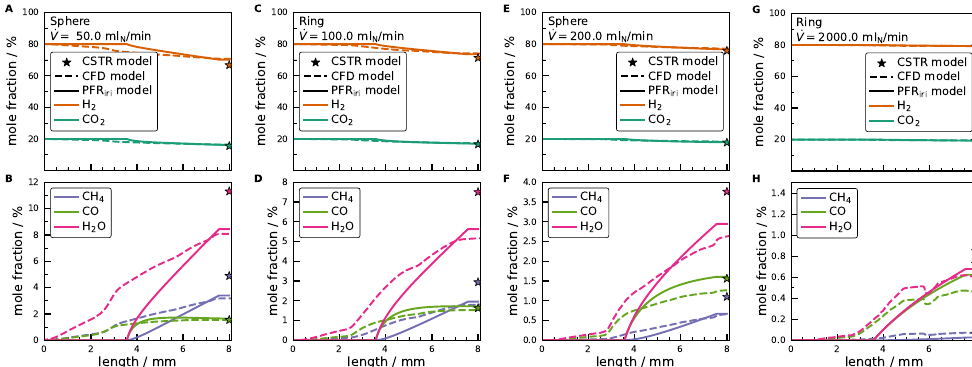
Figure 7. Sphere and ring inside the Temkin single chamber. Comparison between 1D PFR model inert–active–inert (PRF iri ), tanks-in-series (CSTR) model, and 3D CFD simulations of axial profiles of ( top ) reactants and ( bottom ) products mole fractions. ( A , B ) ˙ V = 50 ml N min − 1 , ( C , D ) ˙ V = 100 ml N min − 1 , ( E , F ) ˙ V = 200 ml N min − 1 , and ( G , H ) ˙ V = 2000 ml N min − 1